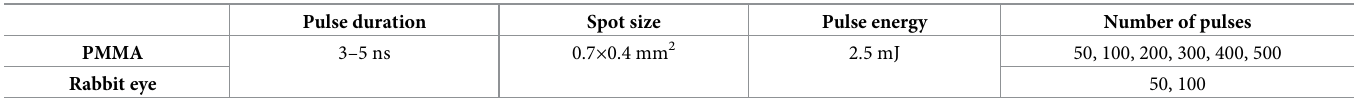
Table 1. Test conditions